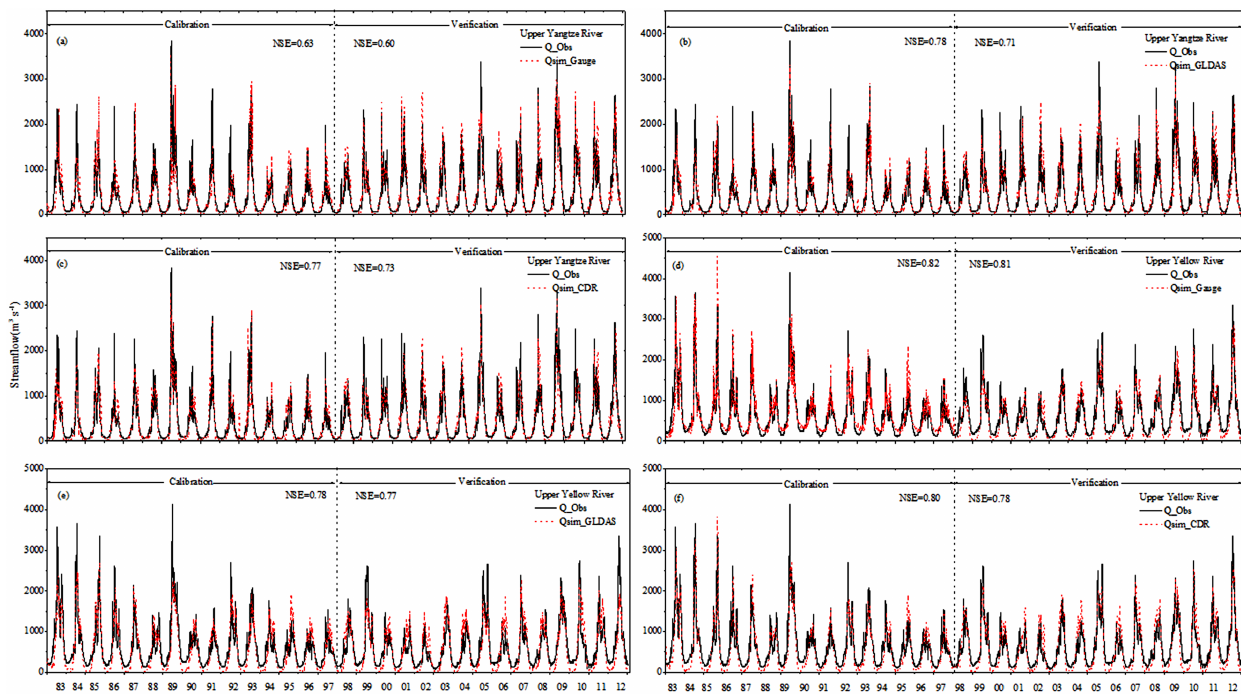
Figure 5. The comparison between the simulated daily streamflow (red) with ground-based, GLDAS, and PERSIANN-CDR precipitation and the observed data (black) at the outlets of the upper Yangtze River basin (a, b, c) and upper Yellow River basin (d, e, f) .